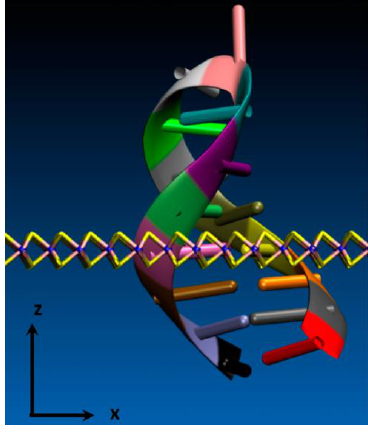
Figure 7. Schematic showing the dimensional scale of an atomically thin MoS 2 nanopore respect to the size of individual nucleotides from a double strand DNA molecule. Adapted with permission from [162] Copyright 2014 American Chemical Society.